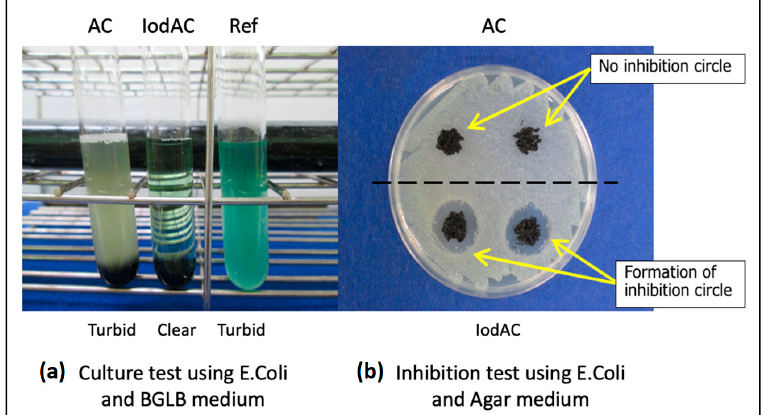
Figure 6. Antibacterial test results: ( a ) turbidity test for bacterial growth in nutrient broth, ( b ) zone of inhibition test for antimicrobial activity on agar plate.